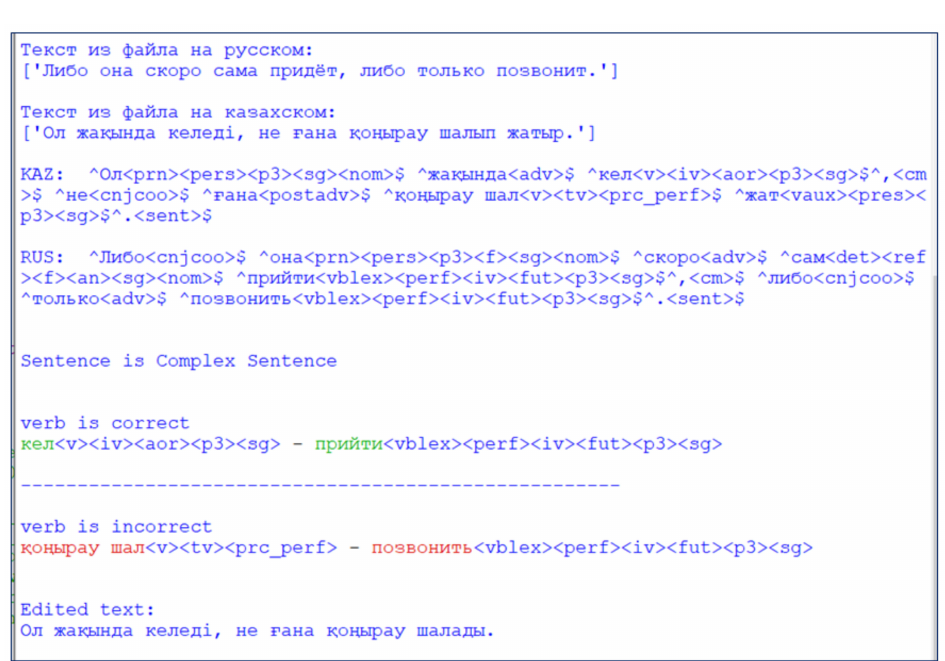
Figure 3. Fragment of the result of the text editing program.